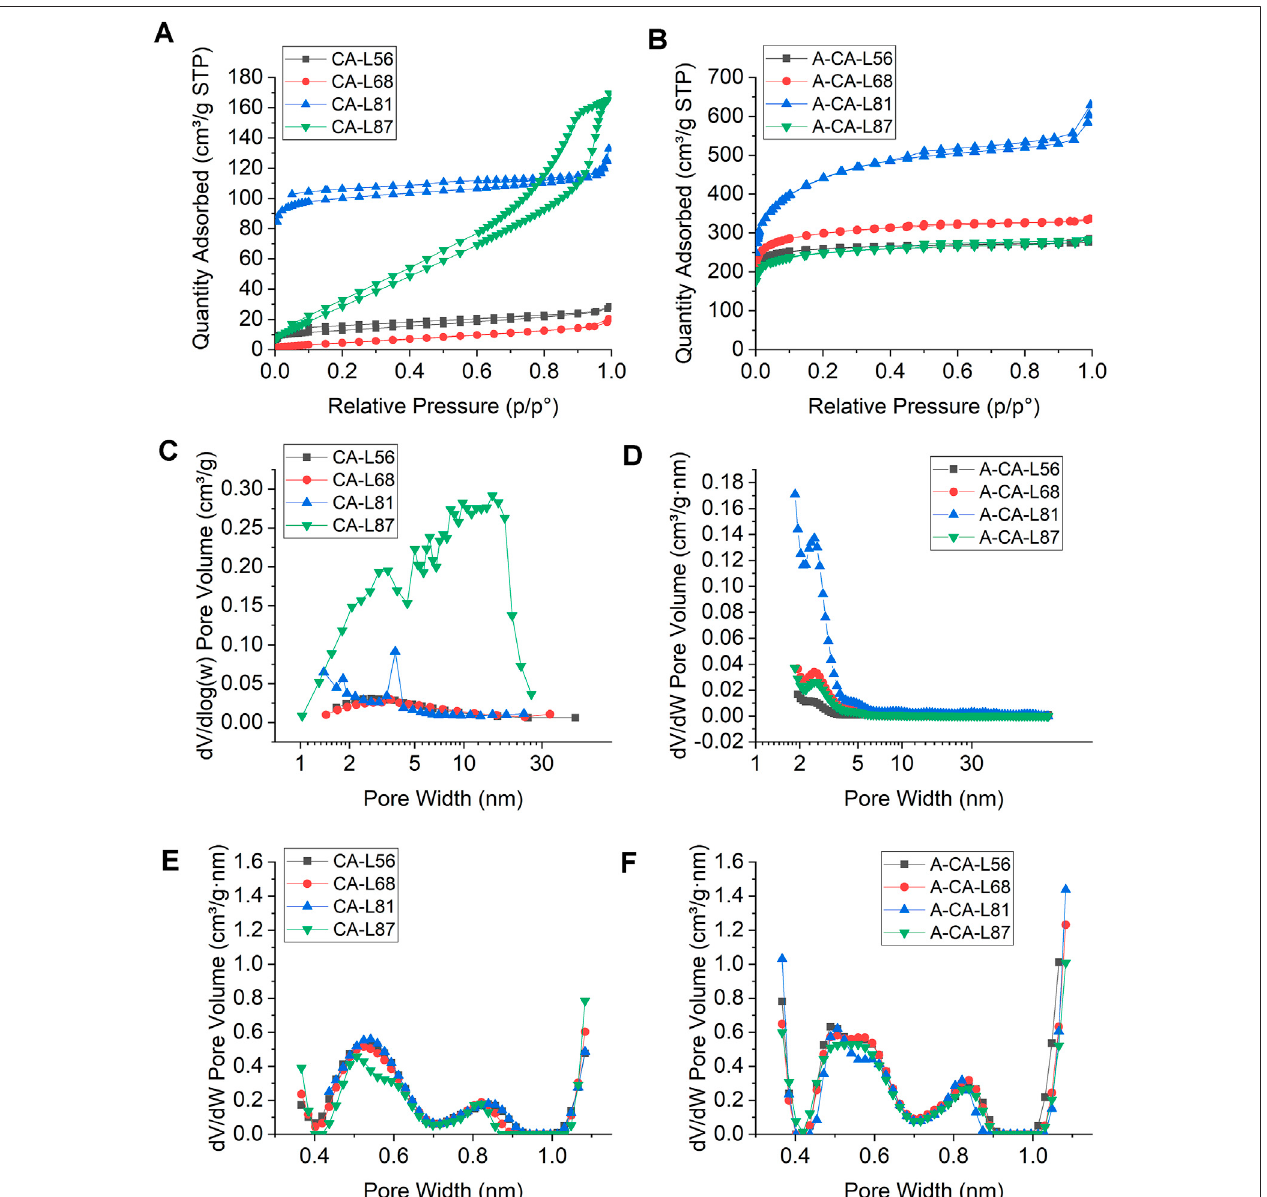
FIGURE5| N 2 adsorption-desorptionisothermsof (A) lignincarbonaerogels(CA)and (B) activatedcarbonaerogels(A-CA)withdifferentlignincontents.Poresize distribution curves of (C) CAs using BJH method and (D) A-CAs using DFT models determined from N 2 isotherms, size distribution of micropores smaller than 1 nm for (E) CAs, (F) A-CAs determined using CO 2 adsorption